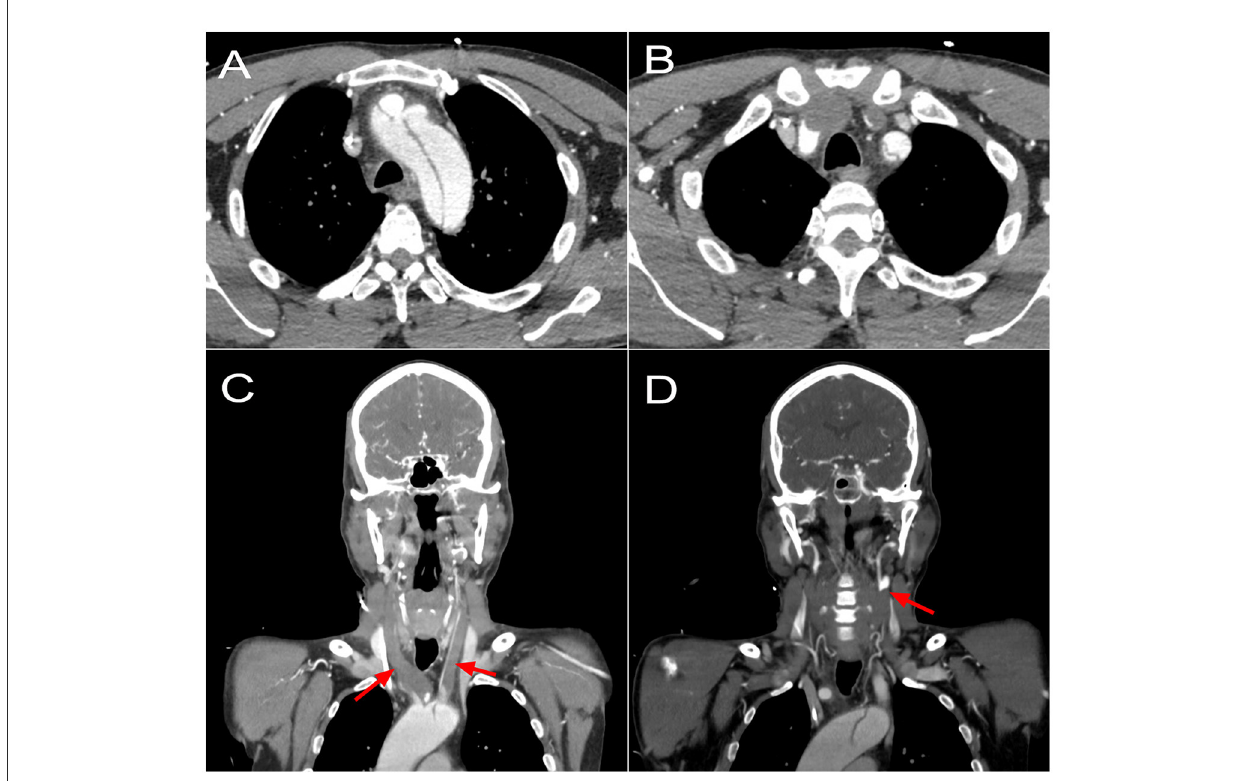
FIGURE1 Preoperative CT scan showing (A) an acute type A dissection compromising the aortic arch and origin of supra-artic vessels. (B) A complete occlusion of the brachiocephalic trunk, with reperfusion of the right subclavian artery; a complete occlusion of the left common carotid artery; a dissected left subclavian artery. (C) A coronal reconstruction showing complete occlusion of both common carotid arteries since origin at the aortic arch (arrows). (D) A coronal reconstruction showing reperfusion at the level of the left carotid bifurcation (arrow).